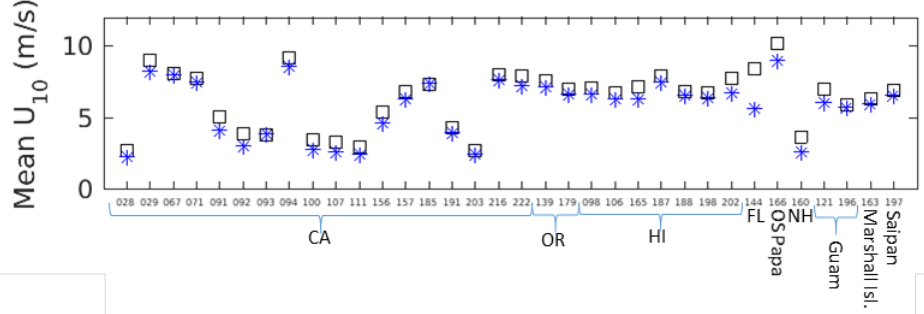
Figure 12. Average wind magnitude at each buoy location for rogue event and non-rogue cases. Rogue event data are depicted by black squares, and non-rogue data are shown as blue asterisks.